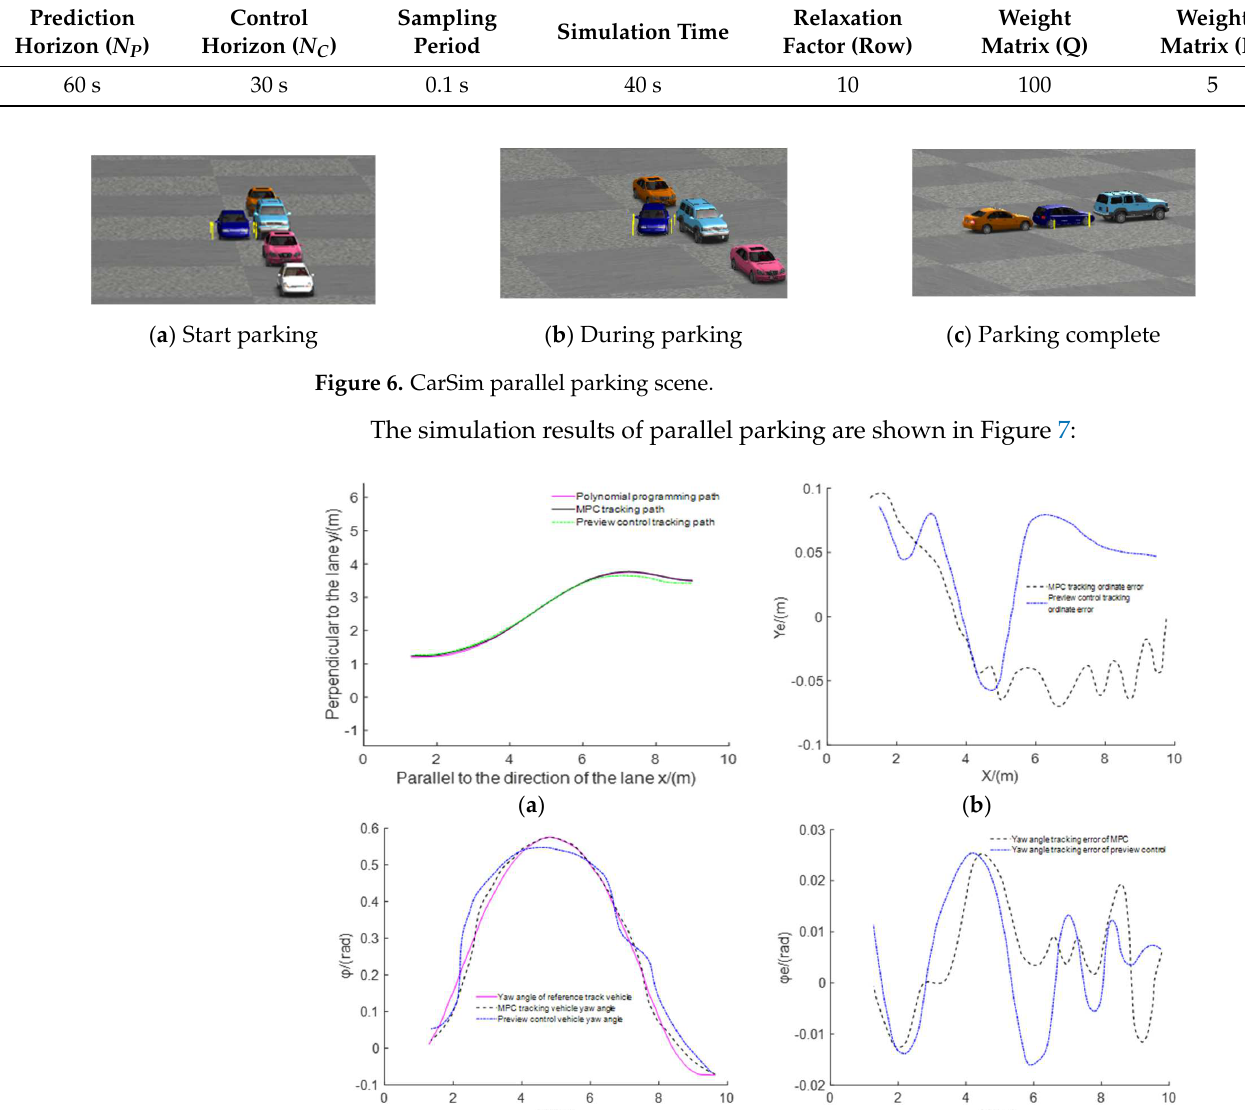
Table 3. MPC controller basic parameters. Figure 6. CarSim parallel parking scene.